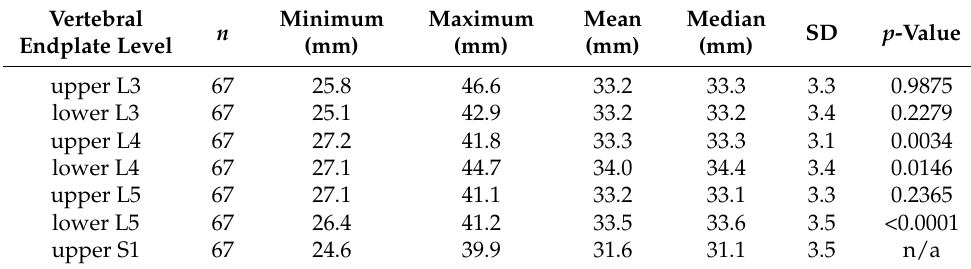
Table 2. Summary statistics of the endplate measurements.